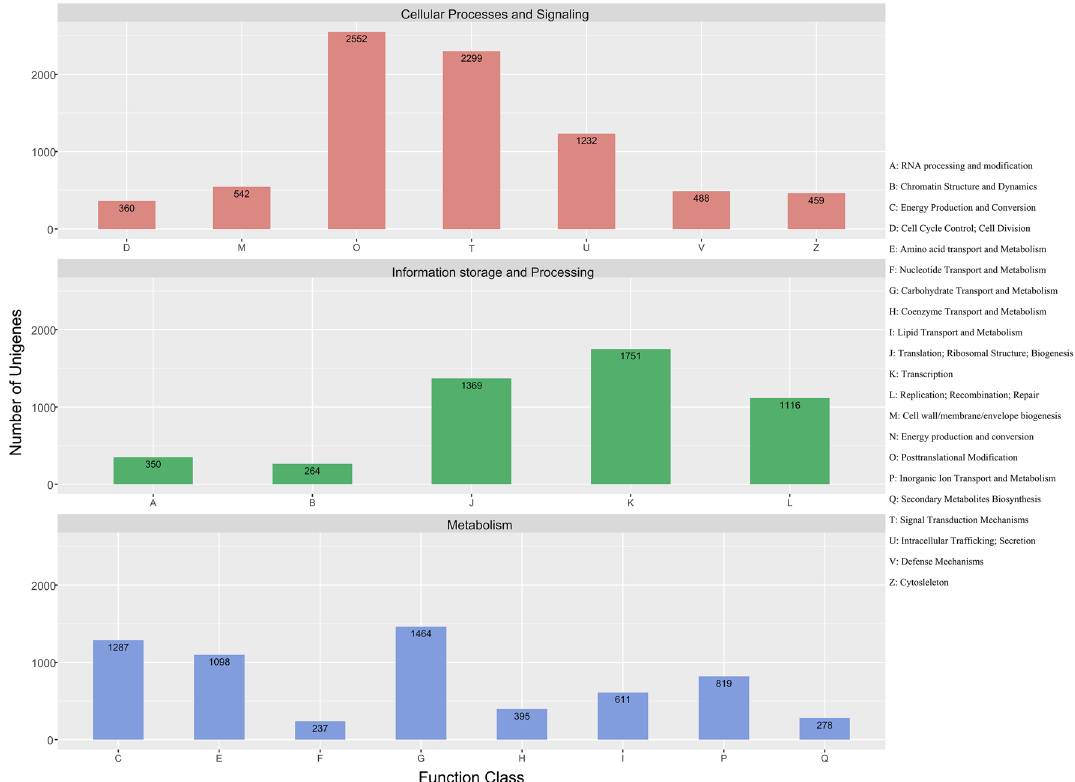
Figure 3. COG functional classification of isoforms.